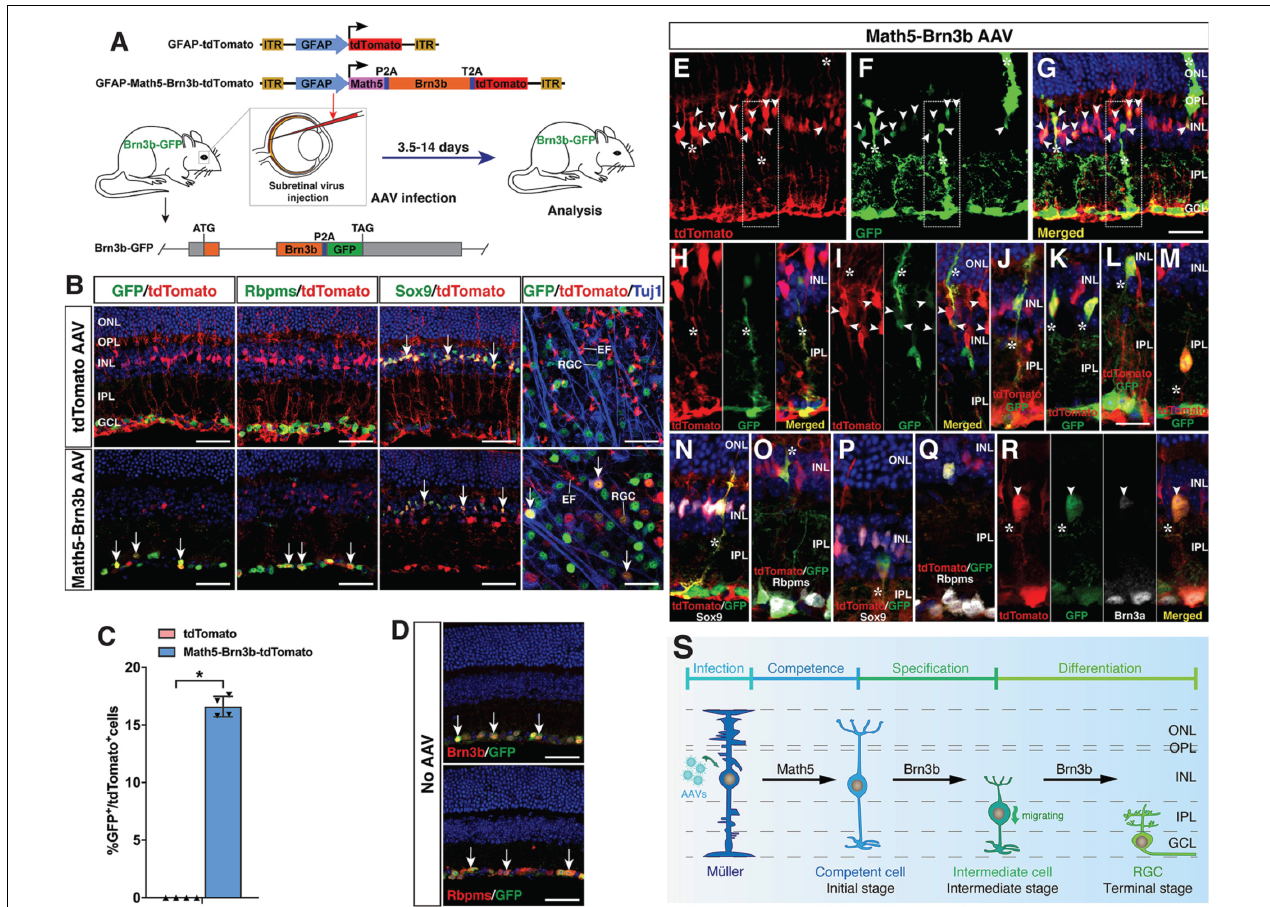
FIGURE 4 | Initial, intermediate and terminal stages of MG transdifferentiation induced by Math5 and Brn3b. (A) Schematic of the AAV constructs and infection procedure to generate RGCs in Brn3b-GFP reporter mice. (B) Two weeks after infection with the indicated AAVs, sections or flat-mounts from infected retinas were double-immunolabeled with the indicated antibodies. Sections were also counterstained with DAPI. Note that fluorescent staining for Rbpms and Sox9 is in manually assigned false green color. Arrows point to representative co-labeled cells. (C) Quantitation of tdTomato+ cells that become immunoreactive for GFP 3 weeks following infection with GFAP-Math5-Brn3b-tdTomato AAVs. Data are presented as mean ± SD ( n = 4). Asterisks indicate significance in unpaired two-tailed Student’s t -test: * p < 0.0001. (D) Sections from retinas of Brn3b-GFP reporter mice without AAV infection were double-immunolabeled with the indicated antibodies and counterstained with DAPI. Arrows point to representative co-labeled cells. (E–R) At day 4–6 post-infection with GFAP-Math5-Brn3b-tdTomato AAVs, sections from infected retinas were double- or triple-immunolabeled with the indicated antibodies and counterstained with DAPI. Shown in (H) is a higher magnification view of the region outlined in (E–G) . (I,J) show more representative images of the initial-stage cells that co-express tdTomato and GFP. (K–M) show intermediate-stage cells located at the inner edge of the INL and in the IPL with the MG morphology lost. Note that the MG-like cells at the initial stage were labeled by tdTomato, GFP and Sox9 but not by Rbpms (N,O) , whereas the bigger cells at the intermediate stage were labeled by tdTomato, GFP, Rbpms, and Brn3a but not by Sox9 (P–R) . Arrowheads point to representative co-labeled cells. Asterisks indicate co-labeled MG-like and other cellular processes. (S) Proposed changes and mechanism during the MG-to-RGC transdifferentiation process. AAV-mediated Math5 expression may confer RGC competence to MG, on which Brn3b may subsequently act to drive RGC specification and differentiation. During reprogramming, MG undergo morphological and molecular changes including losing MG processes and marker expression while gaining RGC morphology and marker expression. EF, MG endfoot; GCL, ganglion cell layer; INL, inner nuclear layer; IPL, inner plexiform layer; ONL, outer nuclear layer; OPL, outer plexiform layer; RGC, retinal ganglion cell. Scale bars = 40 µ m (B,D) , 30 µ m (E–G) , 20 µ m (H–R)